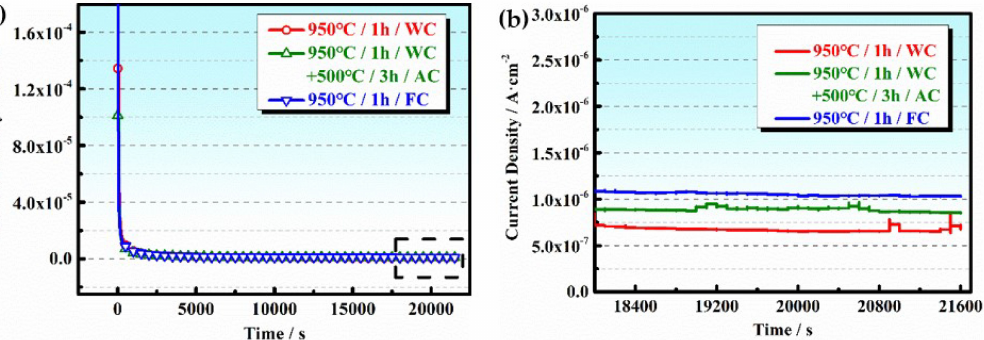
Figure 8. Current transients of heat treated specimens in simulated PEMFC solution at 0.6 V: ( a ) current density-time curves of the specimens, ( b ) magnification of dashed rectangular region marked in Figure 7a.